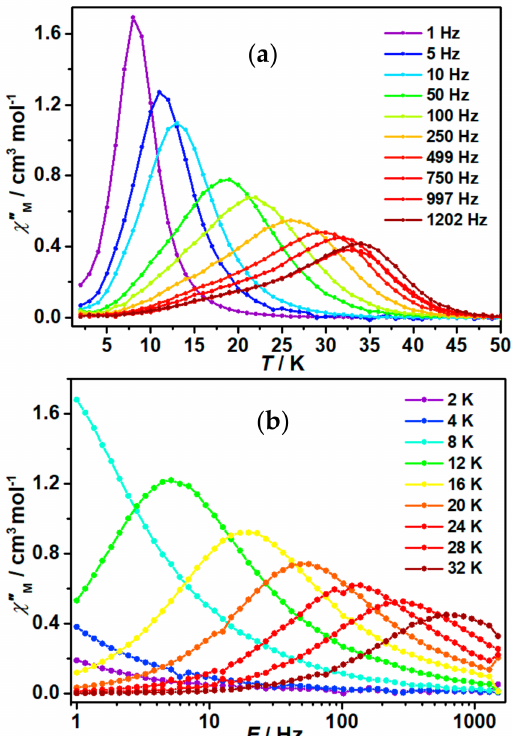
Figure 3. Temperature dependence and frequency dependence of out-of-phase AC susceptibilities